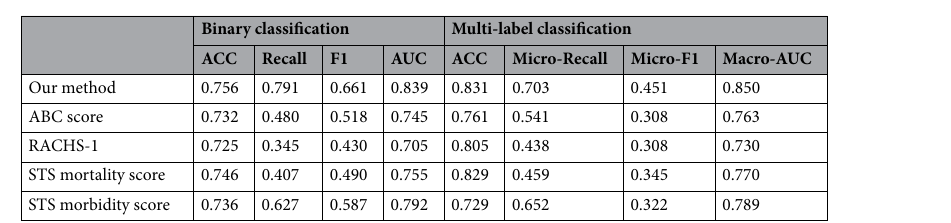
Table 2. Experimental results of binary classification and multi-label classification on the test